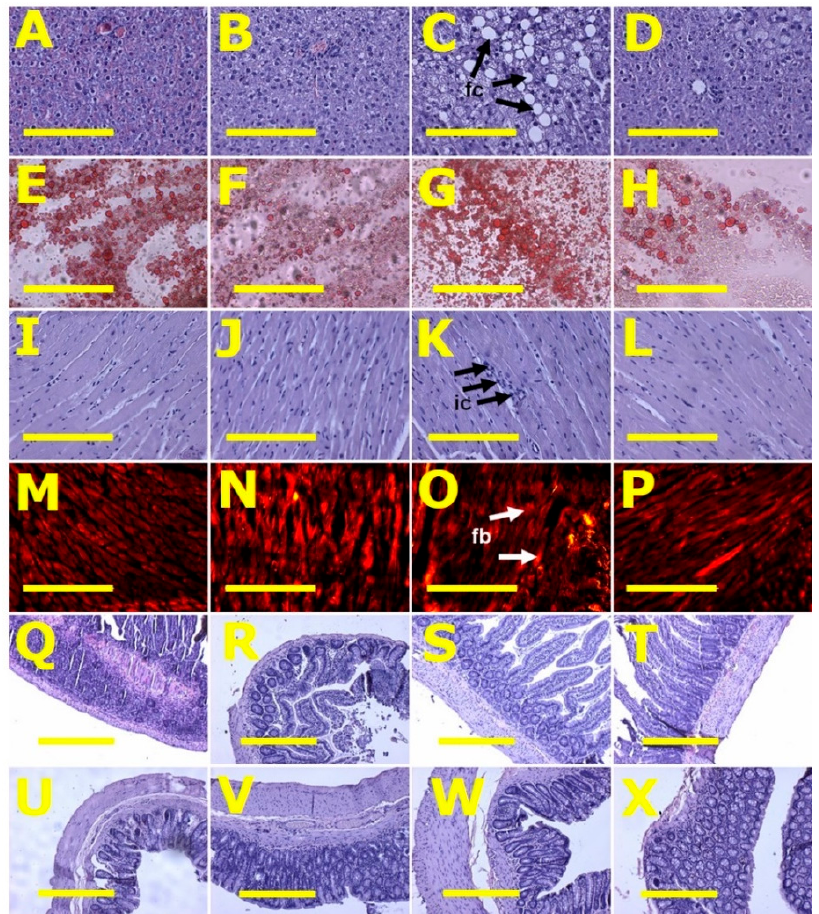
Figure 2. Liver fat structure using haematoxylin and eosin stain ( A – D ) and oil red O stain ( E – H ); left ventricular structure—heart inflammation ( I – L ) using haematoxylin and eosin stain and heart fibrosis ( M – P ) for collagen using picrosirius red staining; ileum ( Q – T ) and colon ( U – X ) structure using haematoxylin and eosin stain in corn starch diet-fed rats ( A , E , I , M , Q , U ), corn starch diet-fed rats supplemented with Caulerpa lentillifera ( B , F , J , N , R , V ), high-carbohydrate, high-fat diet-fed rats ( C , G , K , O , S , W ) and high-carbohydrate, high-fat diet-fed rats supplemented with Caulerpa lentillifera ( D , H , L , P , T , X ). Fat cells = fc; inflammatory cells = ic; fibrosis = fb. Scale bar is 200 µ m for ( A – P ) (20 × ) and 100 µ m for ( Q – X ) (10 × ).